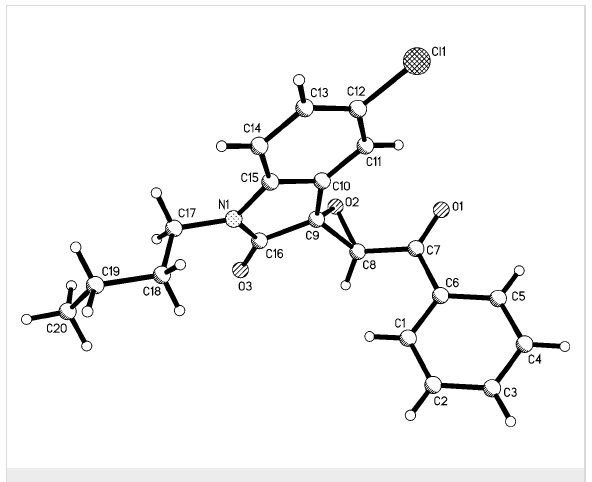
Figure 3: Molecular structure of spiro compound 5o